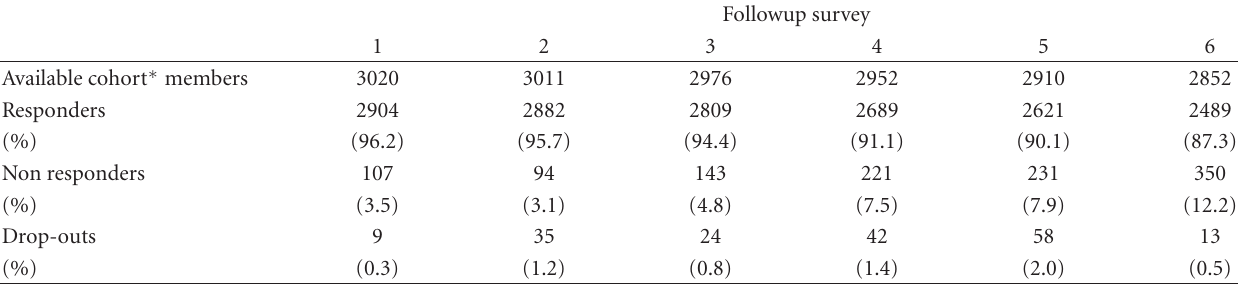
Table 1: Responders, nonresponders, and dropouts at each followup survey, The BROMS Cohort Study,